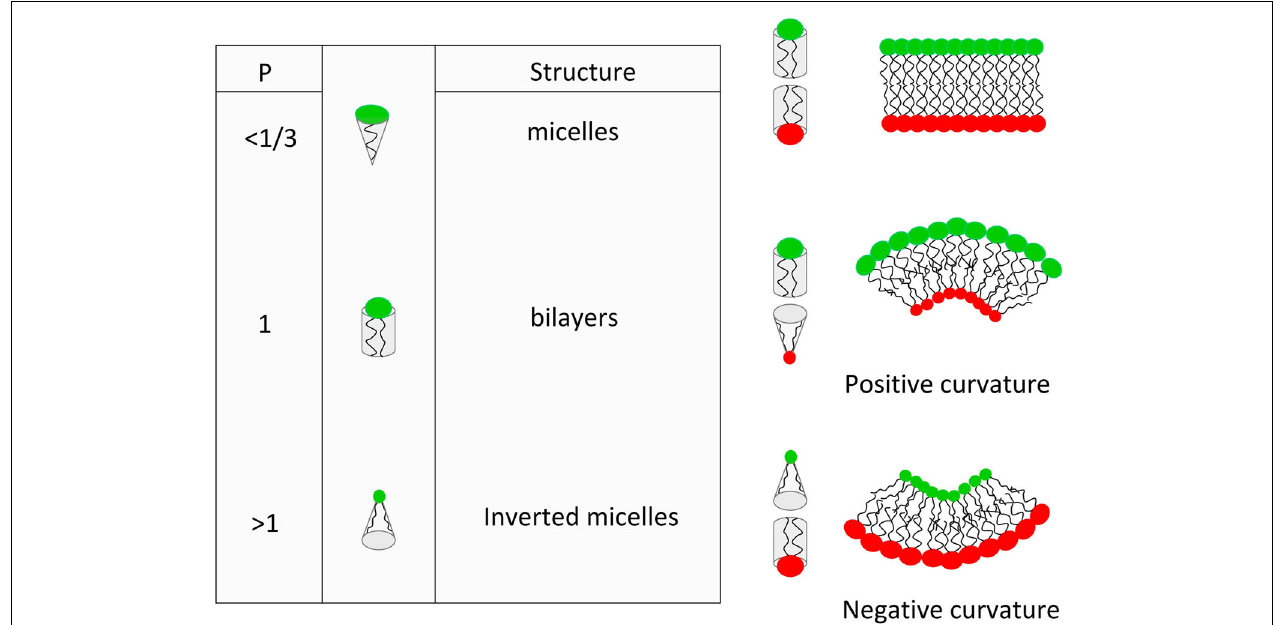
FIGURE 1 | Basic concepts of the lipid average molecular shape and its effect on spontaneous curvature of lipid membranes.